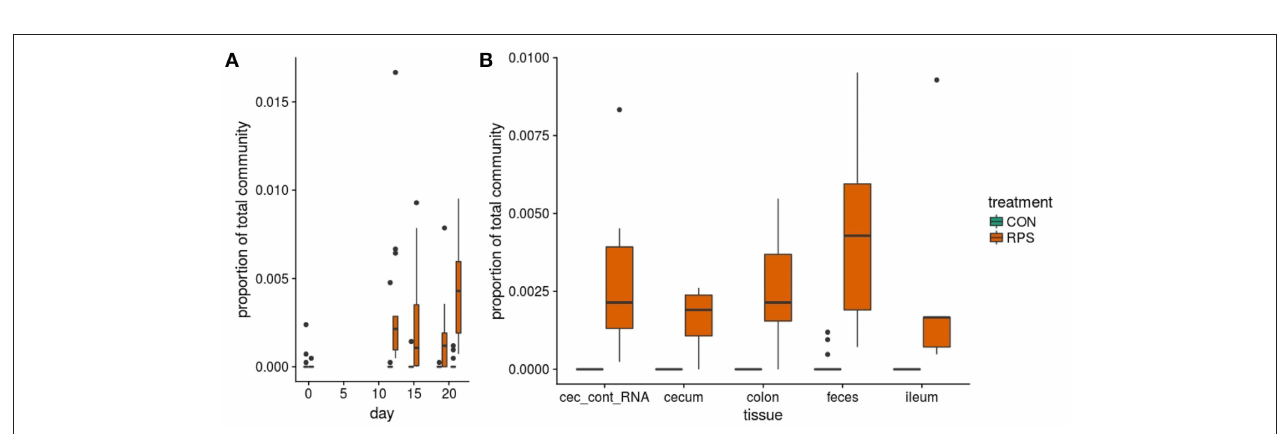
FIGURE 4 | The abundance of OTU0087 over time (A) and in intestinal tissues at day 21 (B) in CON (green) or RPS (orange)-fed pigs. 16S rRNA gene sequences from this OTU most closely matched those from Clostridium chartatabidum , a member of the genus Clostriduim sensu stricto 1. All comparisons between treatment groups are significant by Wilcoxon tests p <